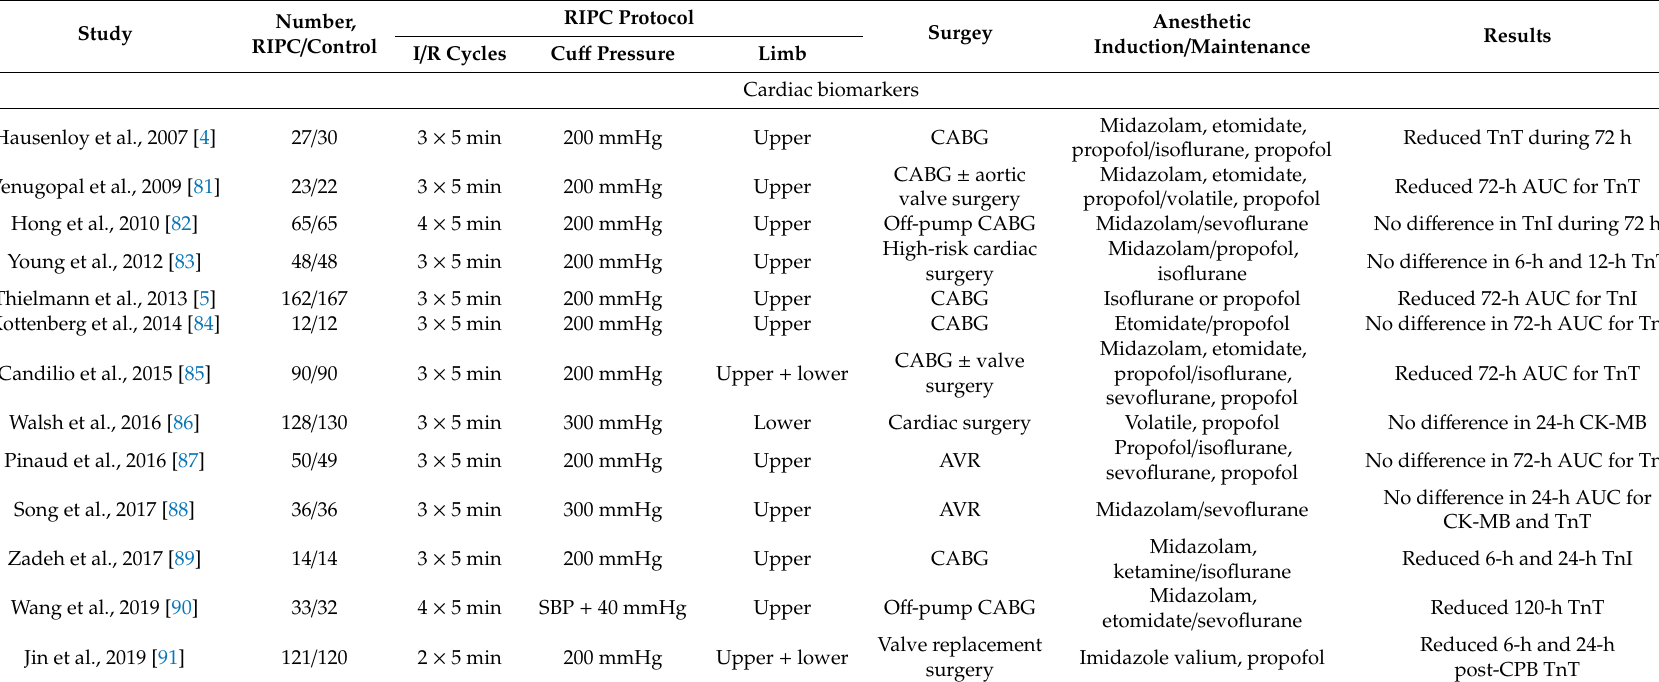
Table 2. Clinical studies on the cardioprotective e ff ect of remote ischemic preconditioning in patients undergoing cardiac